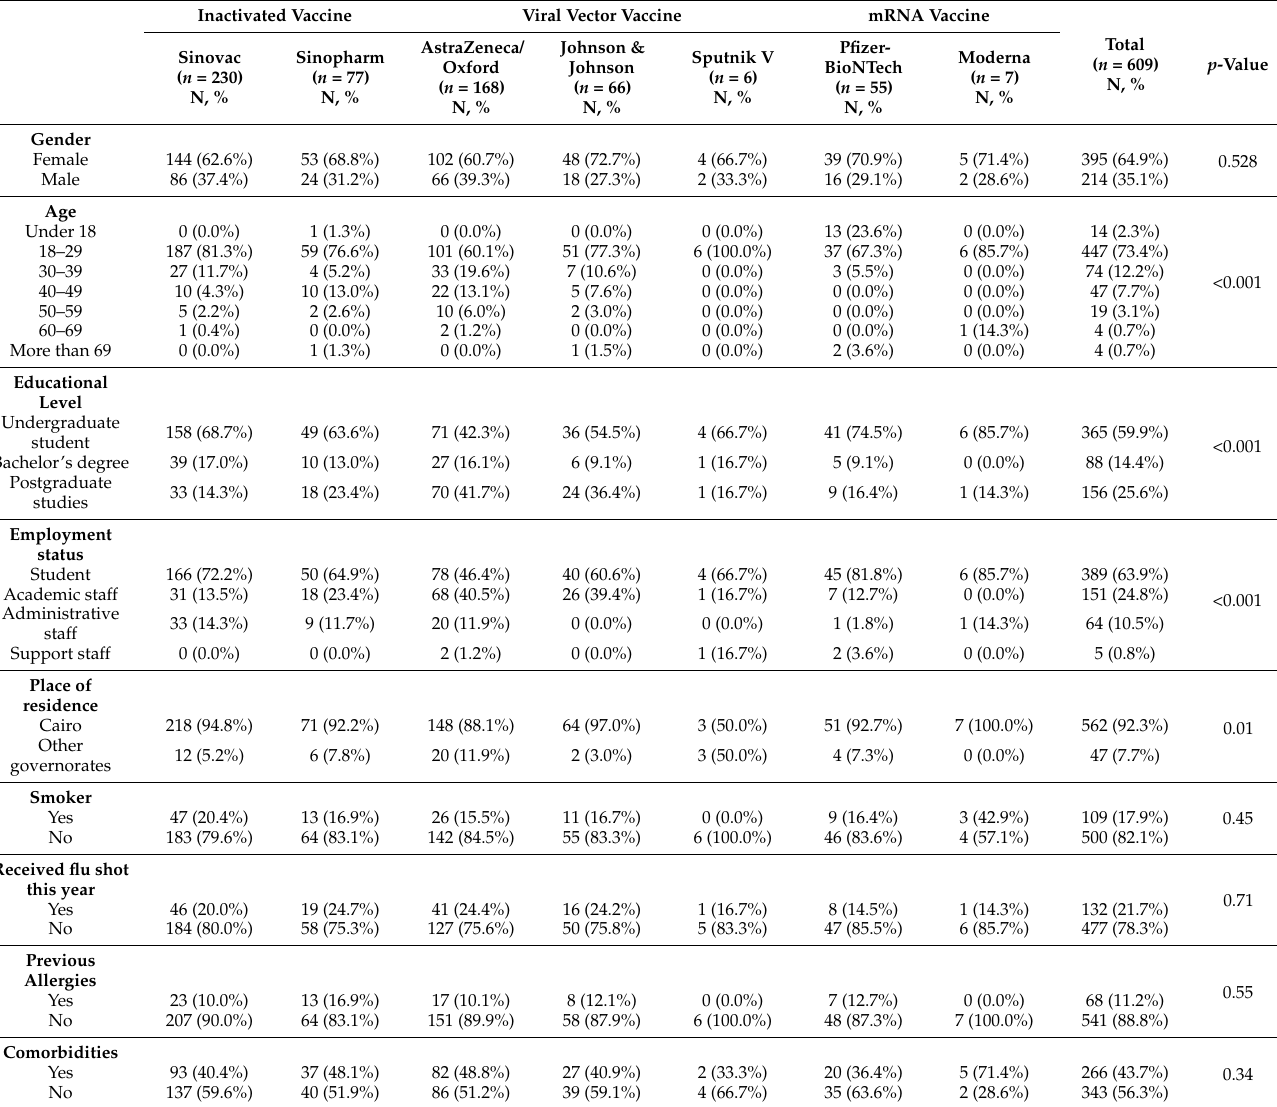
Table 1. Demographic and clinical characteristics of the participants according to type of vaccine ( n =